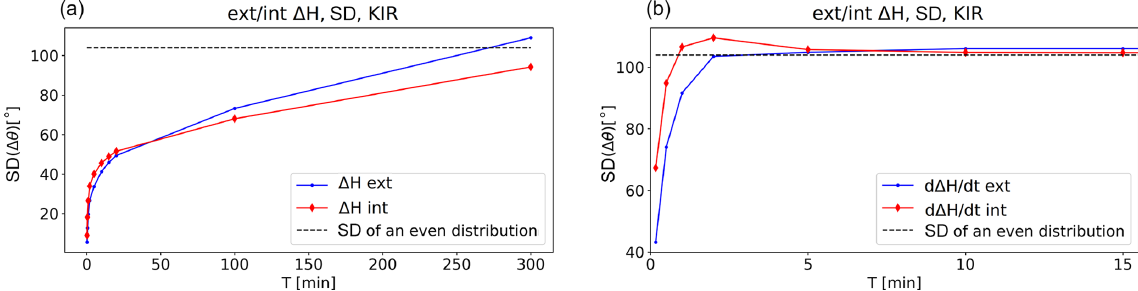
Figure B2. Standard deviation of (cid:49)θ at different time periods, T , using a threshold value 0.5nTs − 1 < | d (cid:49) H / d t | < 1nTs − 1 . (a) External and internal (cid:49) H , and (b) external and internal d (cid:49) H / d t .